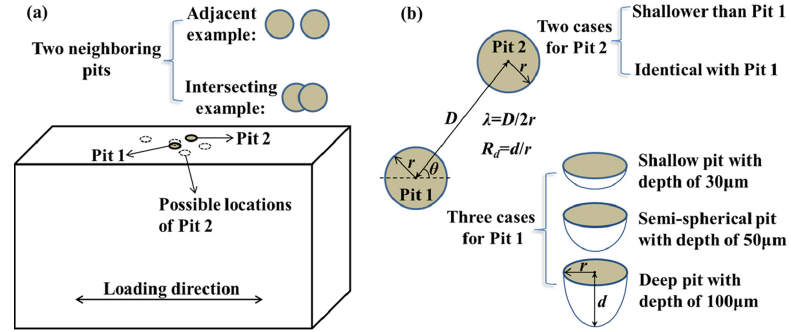
Figure 1. Details of the model containing two neighboring pits. ( a ) Sketch outline of the adjacent and intersecting cases; and ( b ) diagram of the configurations of Pit 1 and Pit 2.